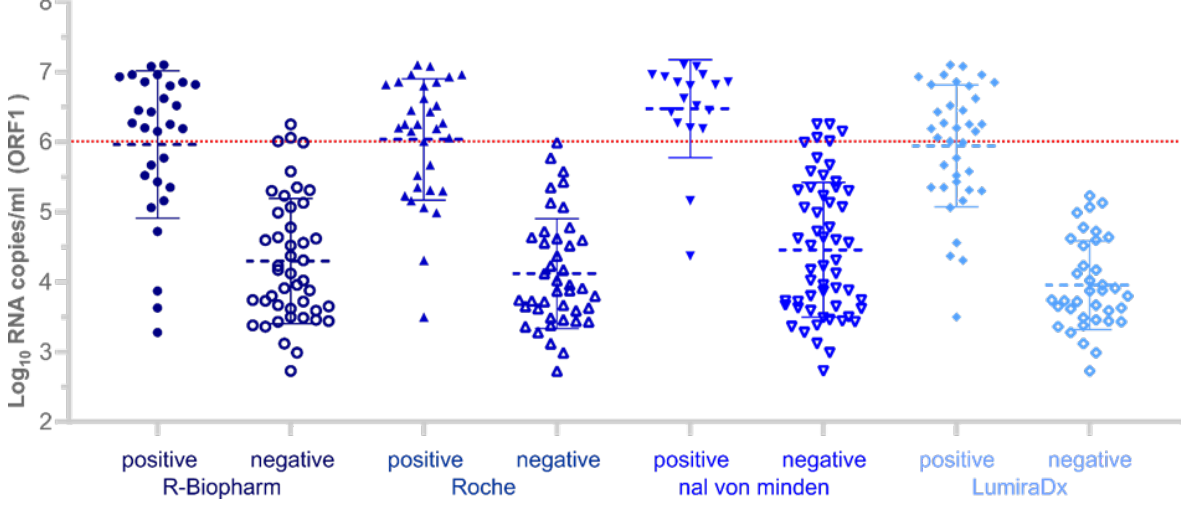
Positive Test with 95% Probability (Values in log 10 RNA/mL)